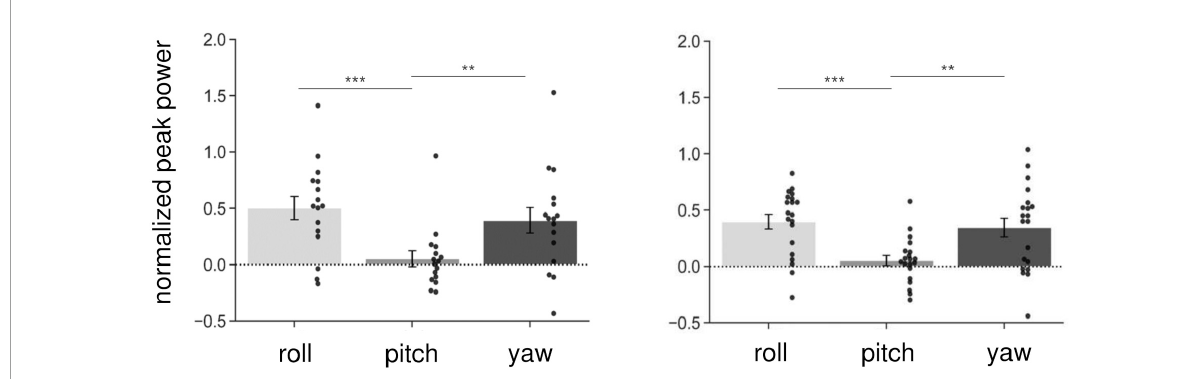
FIGURE3 Normalized peak power on the three axes in Experiment 1 (left) and Experiment 2 (right). As it was normalized, the peak power of the baseline was subtracted from that in the stimulus conditions (Experiment 1: slow, gait, and fast conditions; Experiment 2: in-phase and anti-phase conditions), and then collapsed over stimulations and sessions for each axis. Each dot indicates peak power on each axis for one participant. AC-GVS or combined stimulation increased peak power on the roll and yaw axes compared with the pitch axis. Error bars indicate the standard error of the mean (SEM). ** p < 0.01, *** p < 0.001.